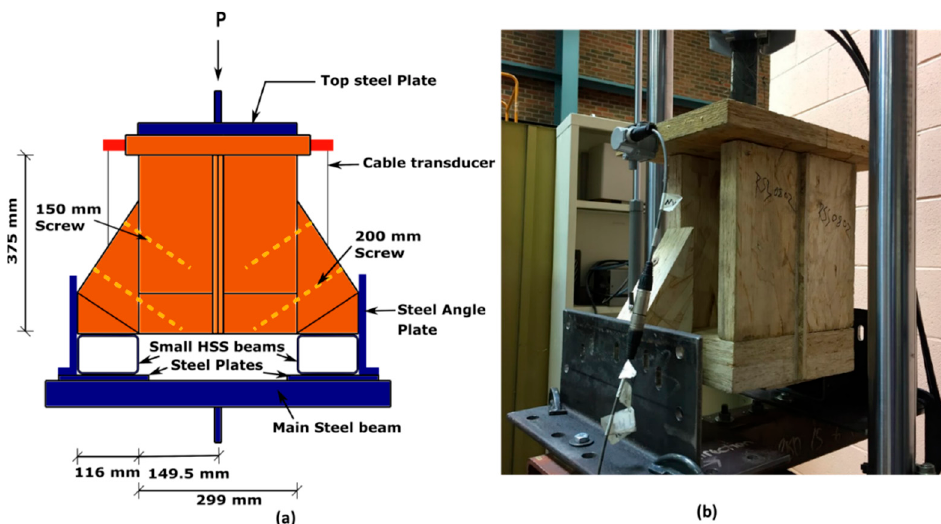
Figure 14. Connection-B test setup: ( a ) schematics; ( b ) actual image.